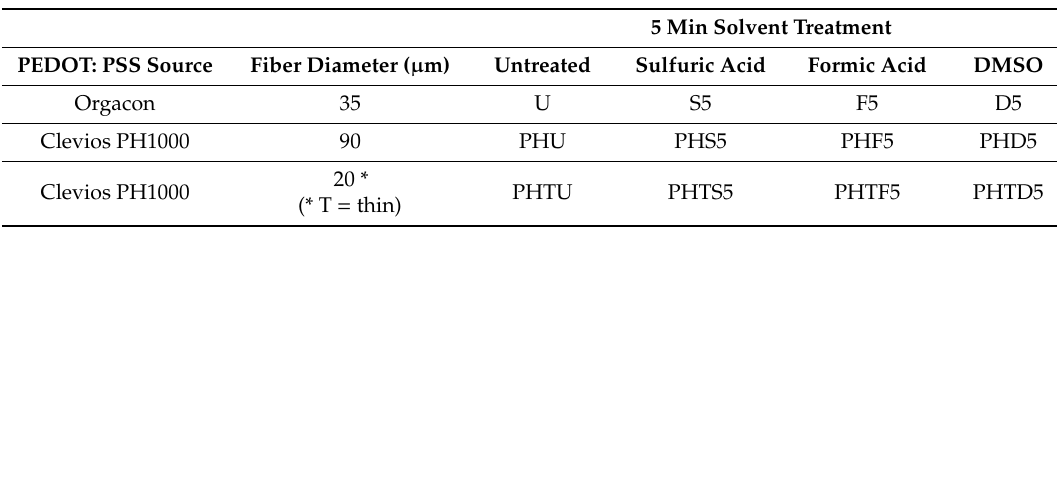
Table 1. Nomenclature of three fiber types spun from Orgacon and Clevios PH1000 PEDOT: